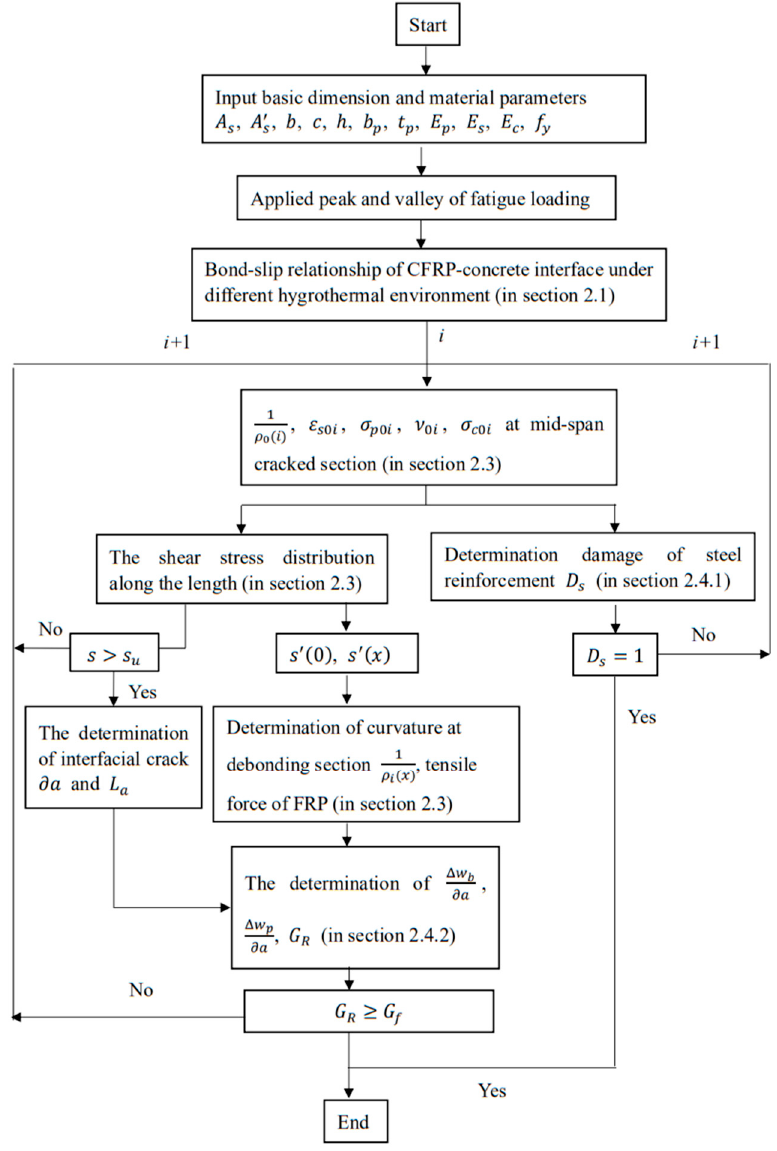
Figure 4. Flowchart for calculation